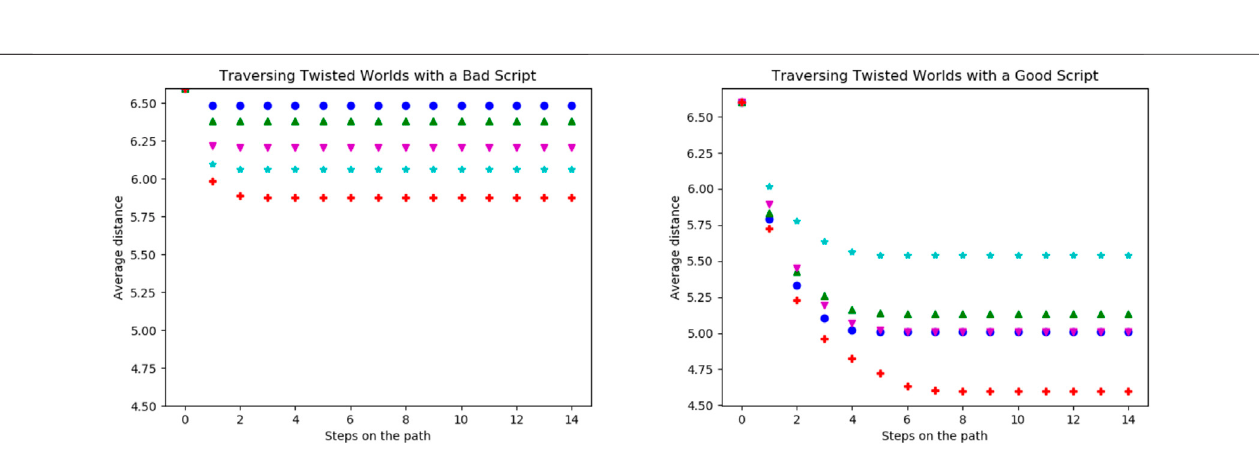
FIGURE 10 | Comparison of the trajectory of the script ( west, east, west, east ) on the left and the script ( west, north, east, north ) in the right in worlds with different twistedness: 0% in blue ( C ), 20% in green ( ▲ ), 30% in magenta ( ▼ ), 50% in cyan ( + ) and 100% in red (+). The achieved distances of the bad script show it is getting better the more the world is twisted. Interesting is also that the good script works exceptionally well in the 100% twisted world. This is due to the fact that for this script many possible good twisted world exist.